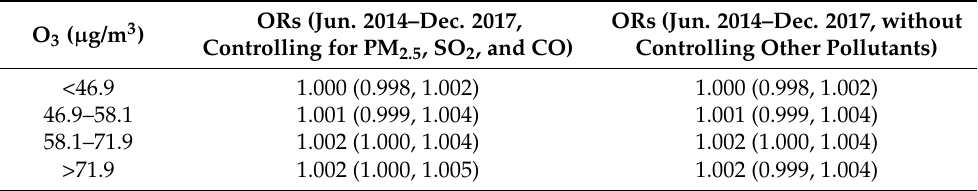
Table 5. Influence of O 3 on gynecological cancers in Phase 4 with/without control of other air